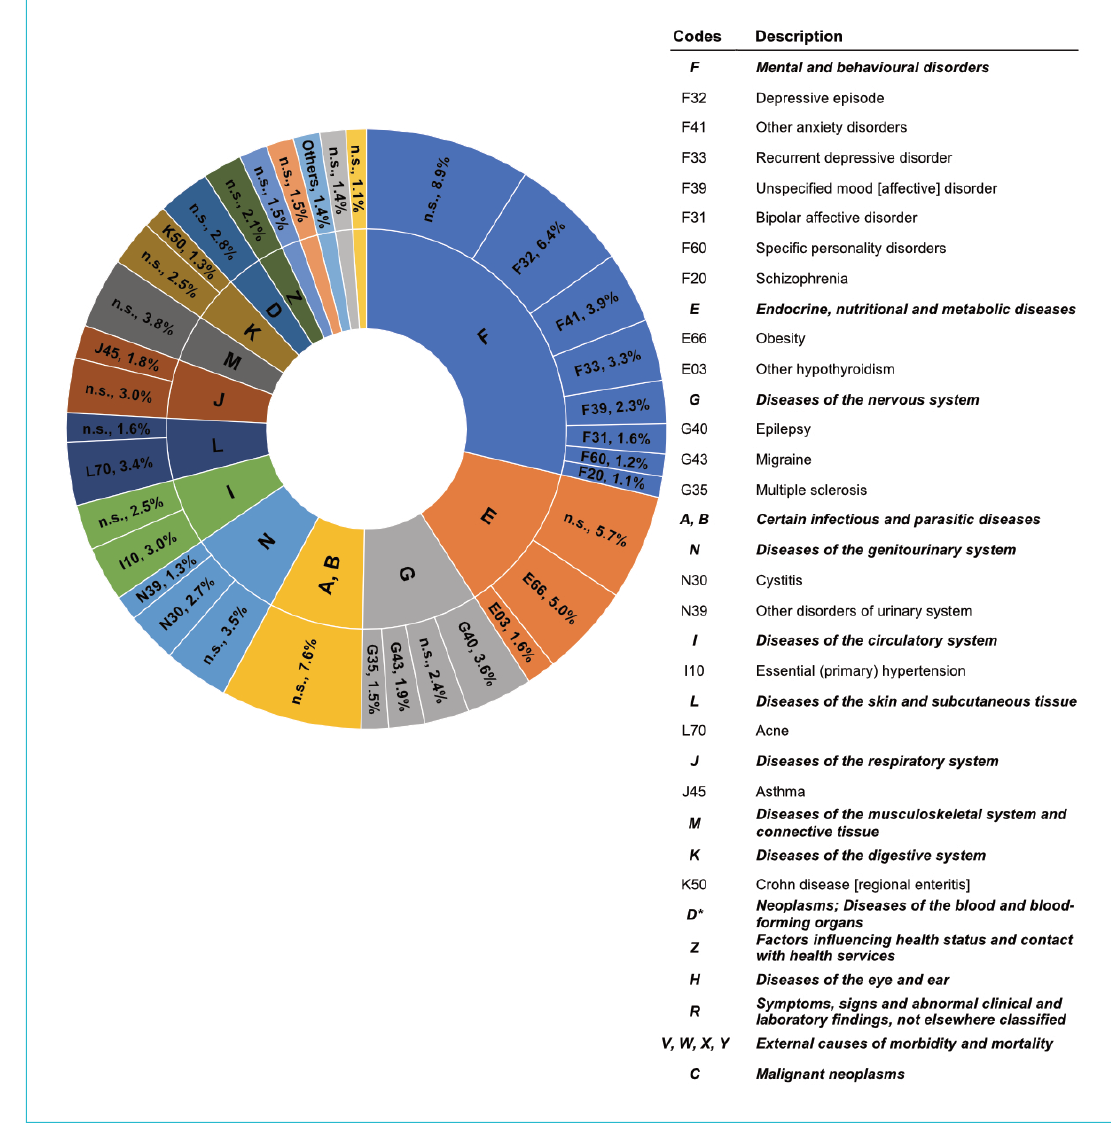
Figure 5: Diagnoses of the mothers mentioned in the queries to the STIS. The ICD-10 classification was used. Note that only the cases of ex- posure to at least one medication during a singleton pregnancy and with available follow-up data were considered (n = 2233). The last five sectors (blue, orange, light blue, grey and yellow) are not labelled for readability reasons and correspond to the codes “H”, “R”, “Others”, “V, W, X, Y” and “C”. *The title of sector D is abbreviated and means “Neoplasms; Diseases of the blood and blood-forming organs and certain disorders involving the immune mechanism” in its full